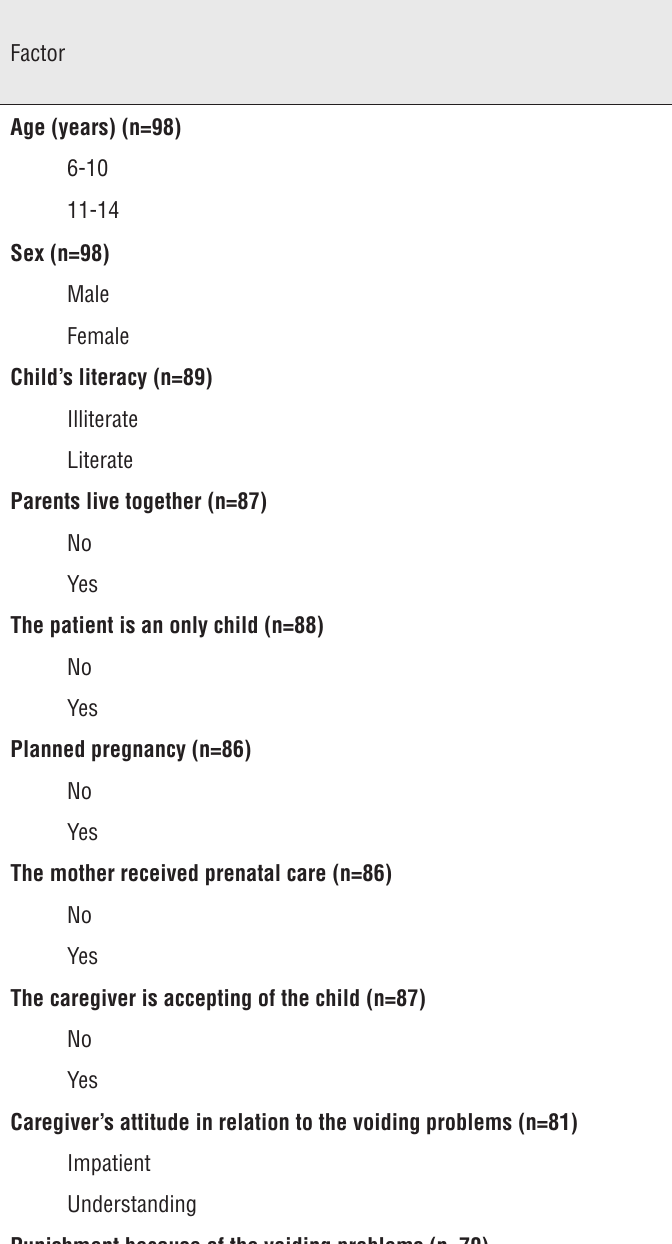
Absence of Stress Presence of stress p-value n